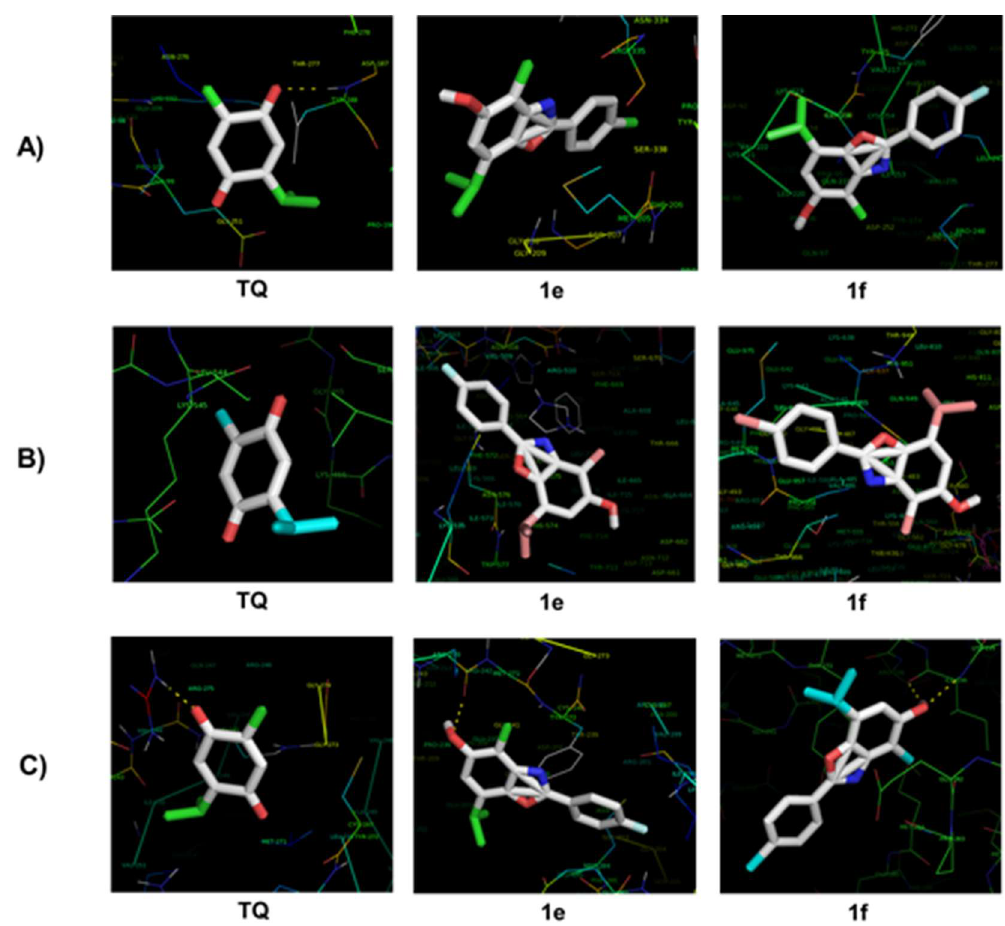
Figure 5. Binding mode of TQ , compounds 1e and 1f at the active site of the ( A ) PTEN receptor (PDB ID: 1D5R), ( B ) topoisomerase II receptor (PDB ID: 3QX3), and ( C ) NF κ B receptor (PDB ID: 1K3Z), as assessed by molecular docking study.